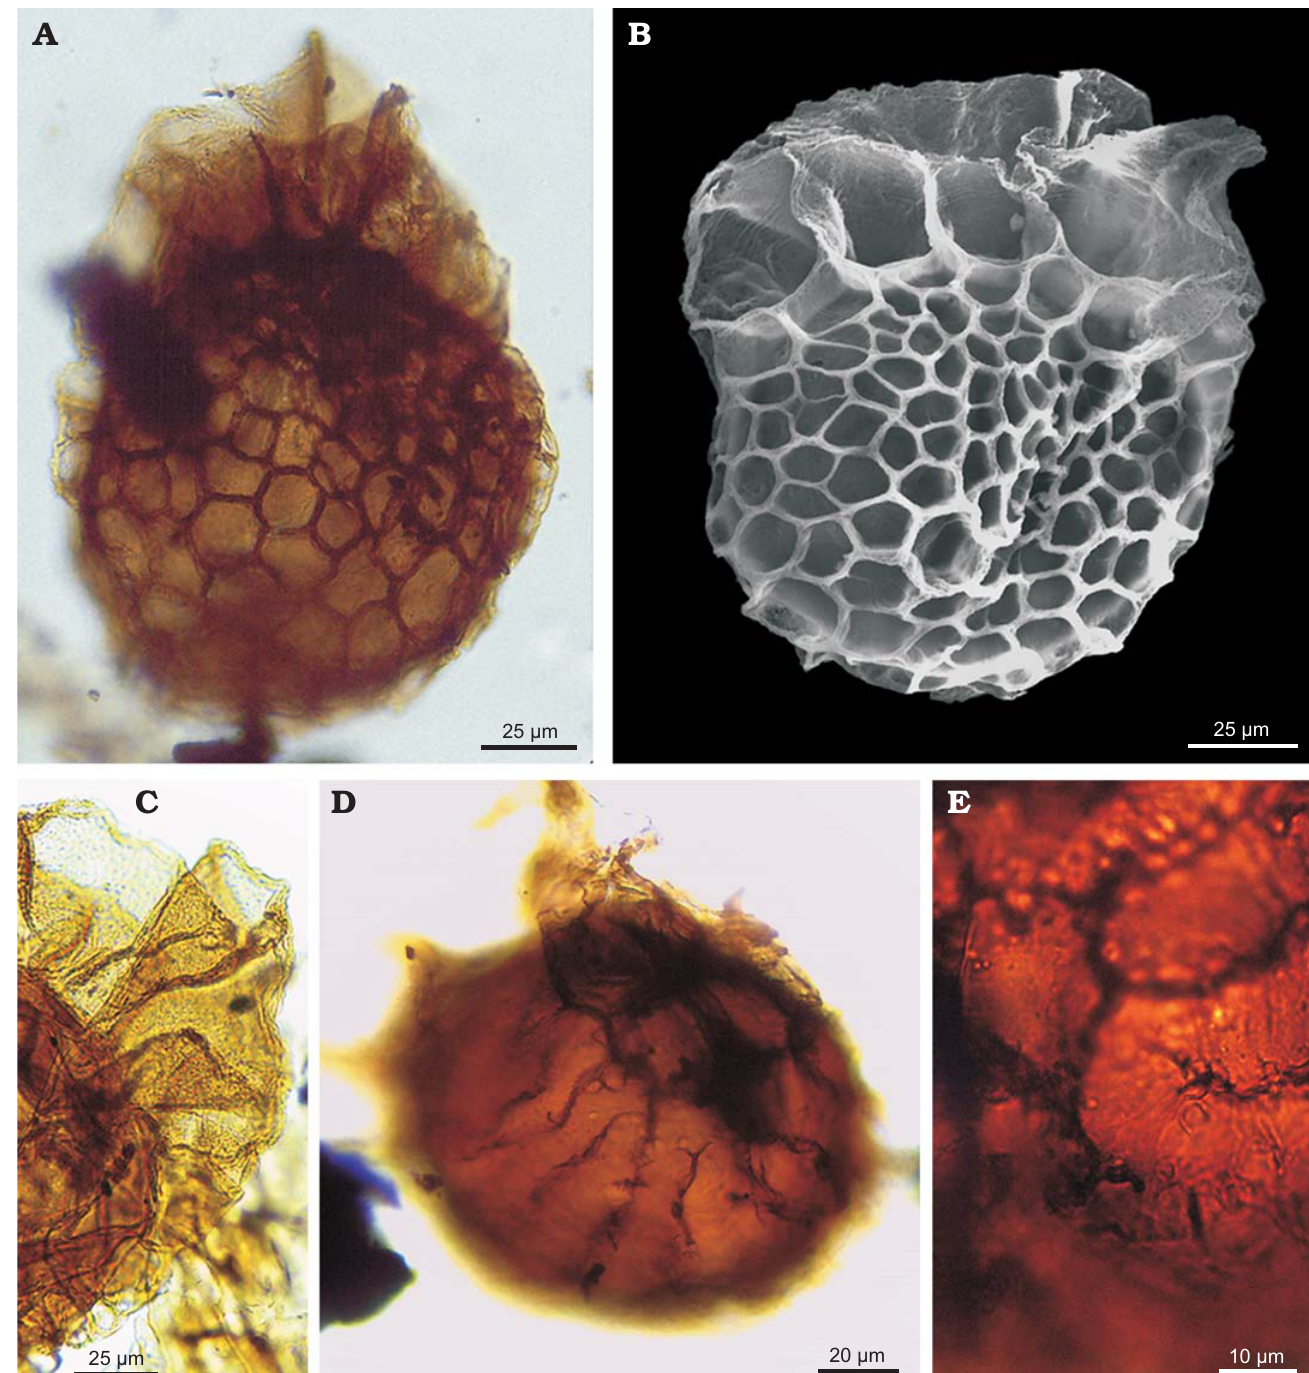
Fig. 4. Megaspores of the water fern Balmeisporites cf. B. holodictyus Cookson and Dettmann, 1958; Cenomanian, town of Tres Lagos, Argentina. A . MPM-Pb-18907a (H32/4), general view under light microscope. B . MPM-Pb-18907 SEM stub 1, general view under SEM, showing the larger reticu- lum in the equatorial region. C . MPM-Pb-18907a (Q49/1), detail of finely granulated lips. D . MPM-Pb-18907a (F39), general view of one individual with variations in reticulum development. E . MPM-Pb-18907a (J53/3), detail of the variations in reticulum